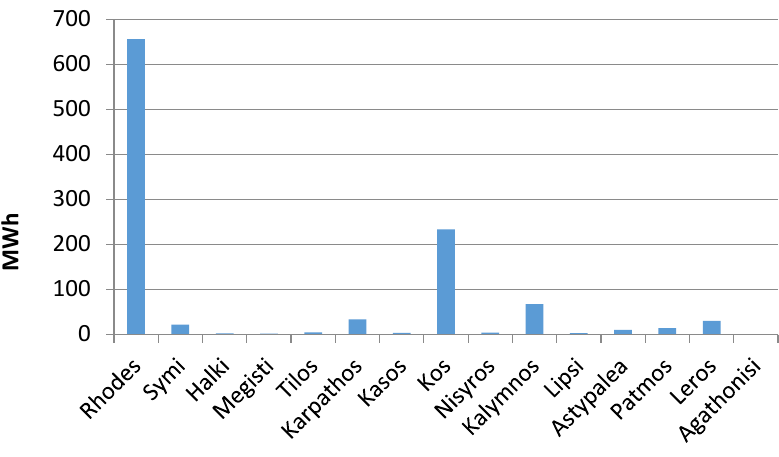
Table 2. Electricity consumption reduction (electricity demand) at village and agricultural land level, year 2012 [53].